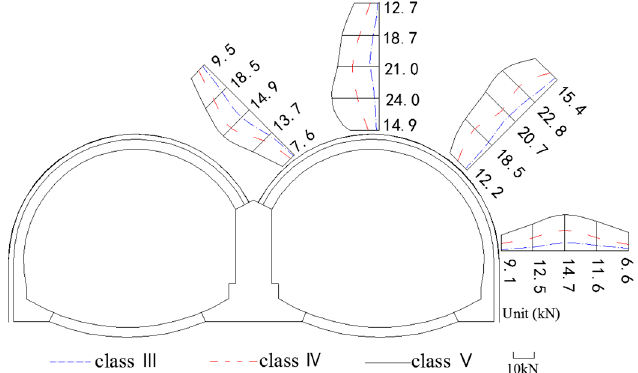
Figure 18. Final distribution of the axial forces in rock bolts in different sections respectively corresponding to class III, IV and V surrounding rocks. The values in the figure are the axial forces in rock bolts in class V surrounding rocks.